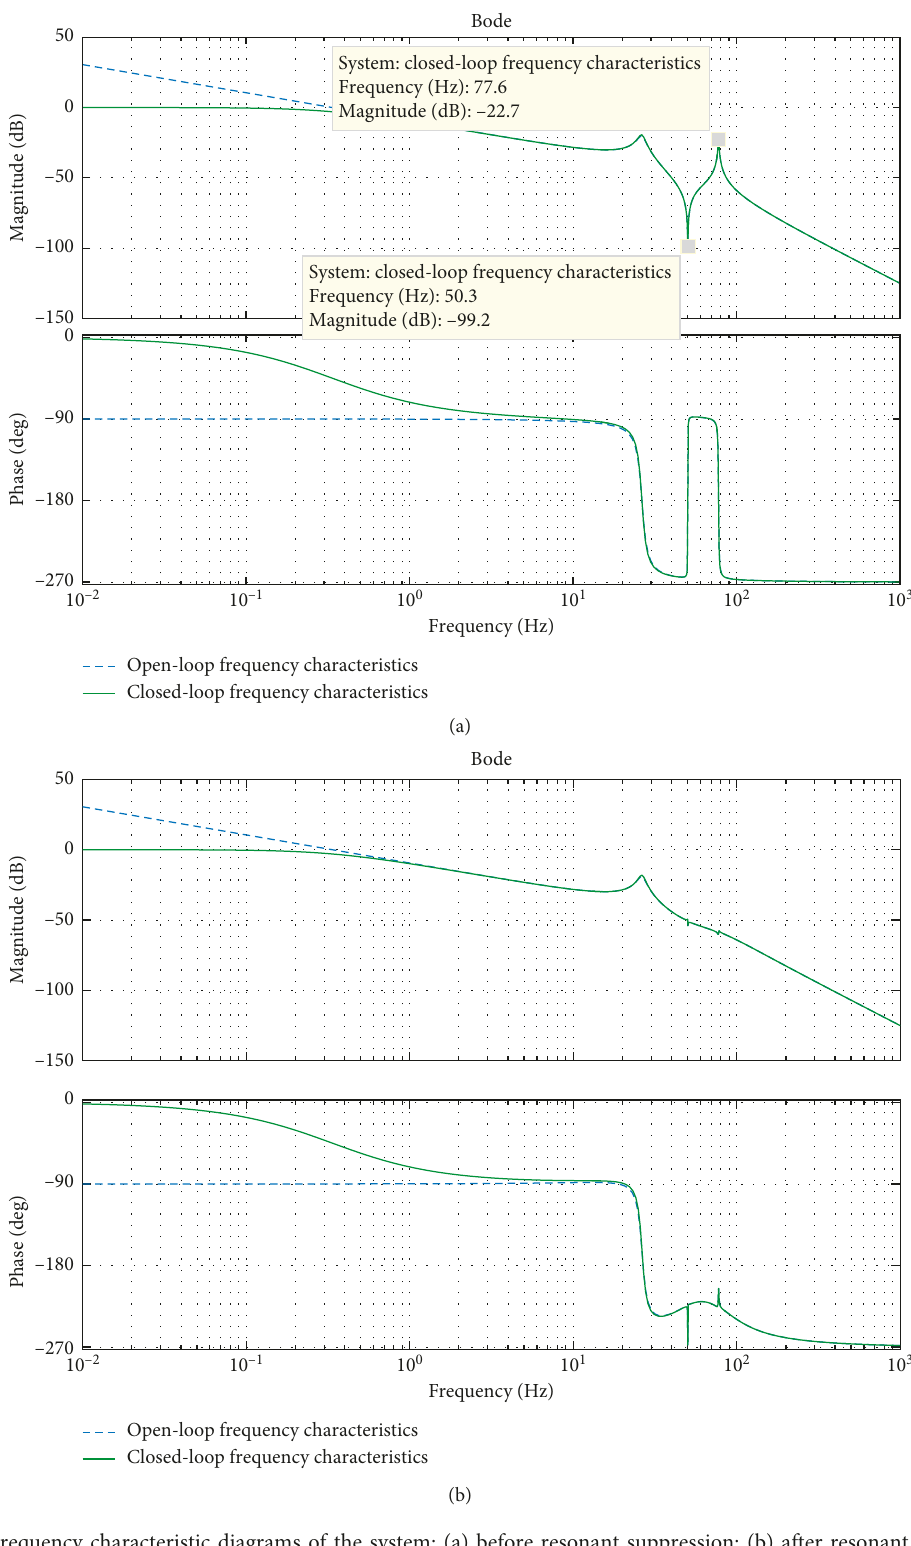
Figure 9: Frequency characteristic diagrams of the system: (a) before resonant suppression; (b) after resonant different load stiffness, MATLAB simulates the resonant based on the LMS algorithm by studying the resonant suppression and verifies the effectiveness of multifrequency frequency and the frequency characteristic of the adaptive adaptive notch filter. trap at the zero point in the unit circle. Considering the